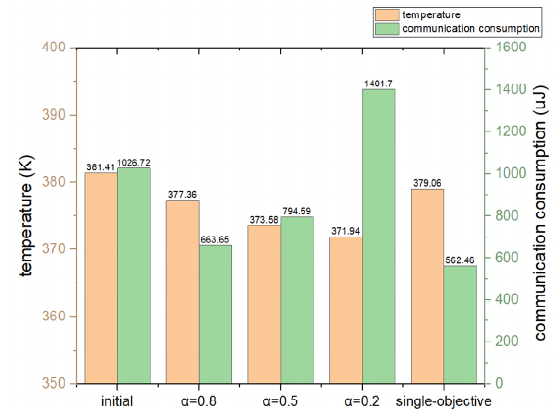
Figure 10. Temperature and communication consumption of di ff erent layouts.